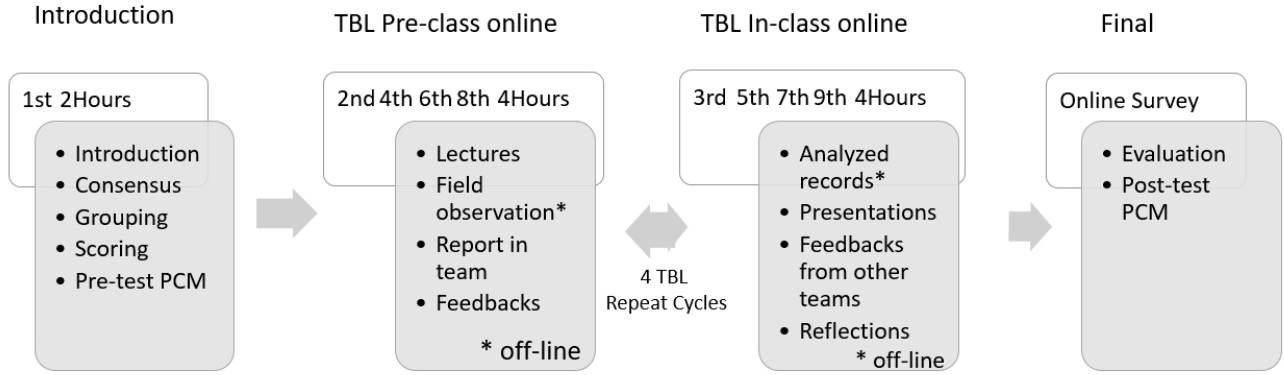
Figure 1. The process of conducting “Nursing and Life” online TBL course (9 weeks biweekly). TBL: online team-based learning; PCM: peer caring measurement. *, offline learning.